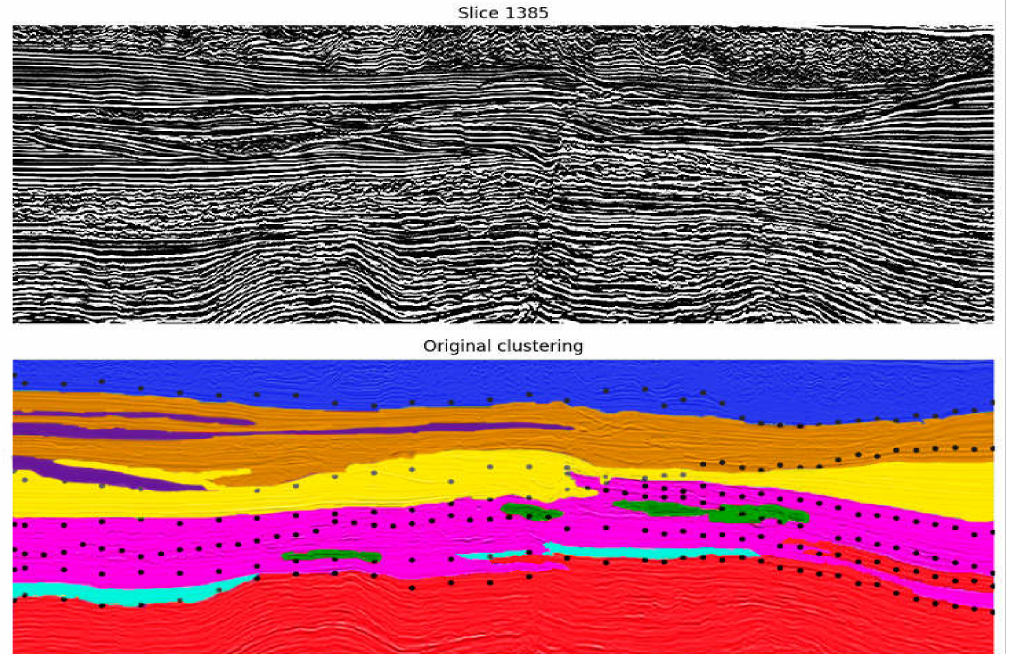
Figure 14. Results from the clustering of Watershed segments using k-Means (8 groups) and an image composed of Texture Dissimilarity, Amplitude, Similarity Cross Average. The top image shows the original vertical seismic slice; the bottom one shows the Watershed results. Black dots in the lower figure indicate main geological boundaries according to geophysicist interpretation of the top figure (conventional seismic data). One can conclude that a good fit occurs between clustering results and geophysicist’s preliminary